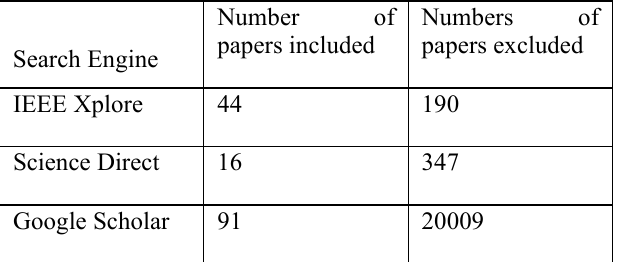
Figure (b). Private e-health cloud system.